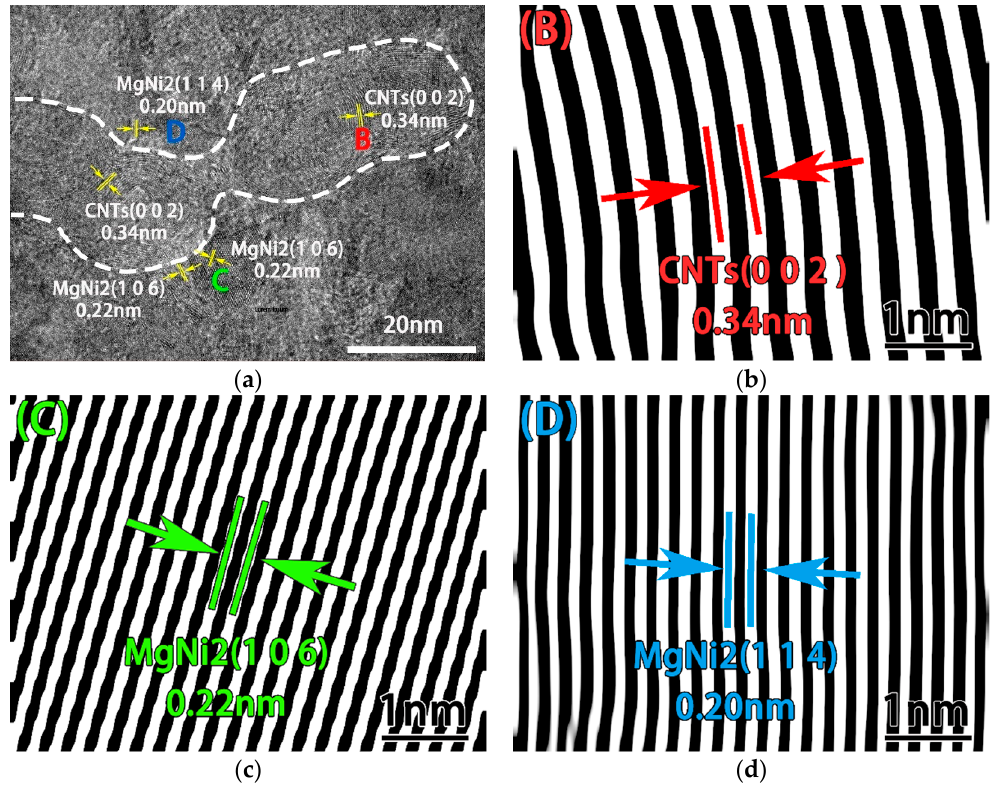
Figure 7. Grain size of CNTs/Mg composites prepared by Mg powder grinded for different times.